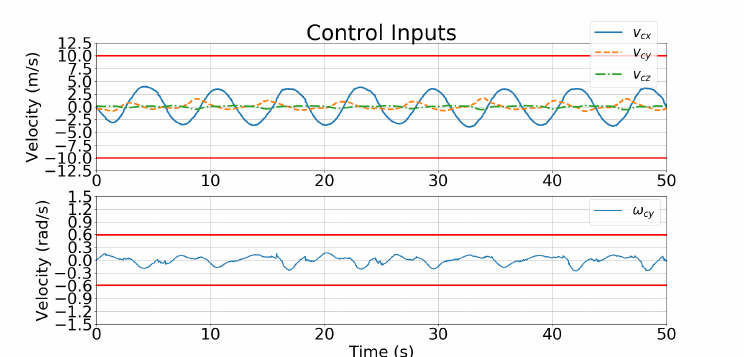
Figure 12. Simulation 1: velocity control input for Case 2.